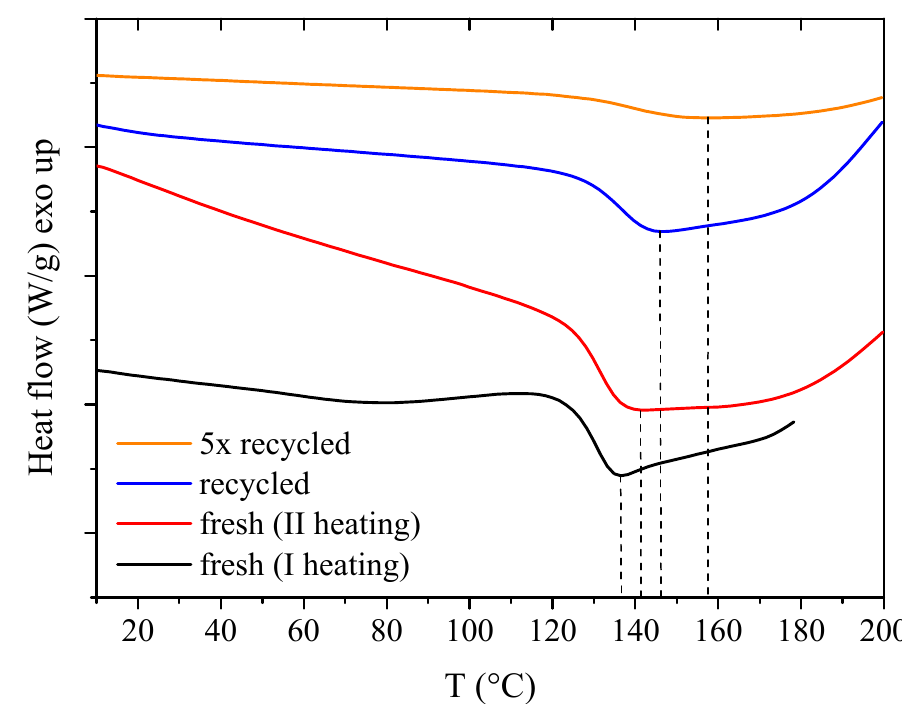
Figure 2. Differential scanning calorimetry (DSC) traces (heating scans) of M22 DA polymer network: Freshly synthetized (2 consecutive thermal cycles); compression molded; after five molding processes. Dashed lines indicate peak temperatures of retro-Diels–Alder.